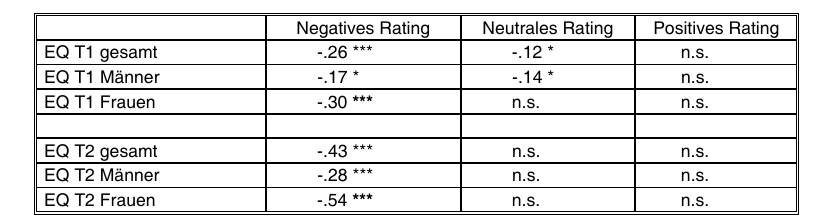
Korrelative Zusammenhänge zwischen der Tönung der